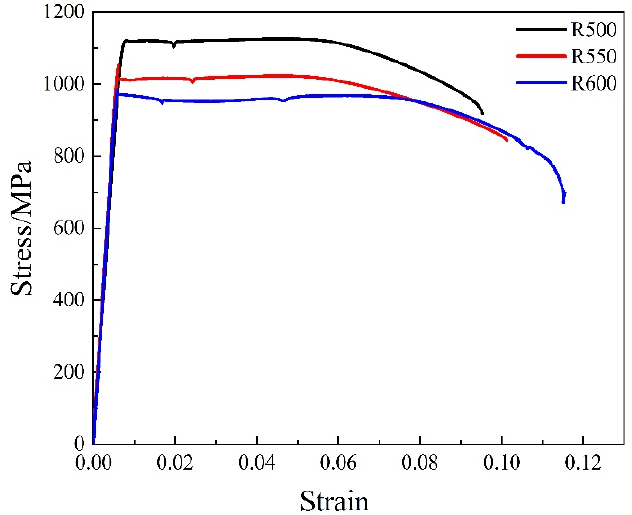
Figure 6. Stress–strain curve of samples warm rolled at different temperature.